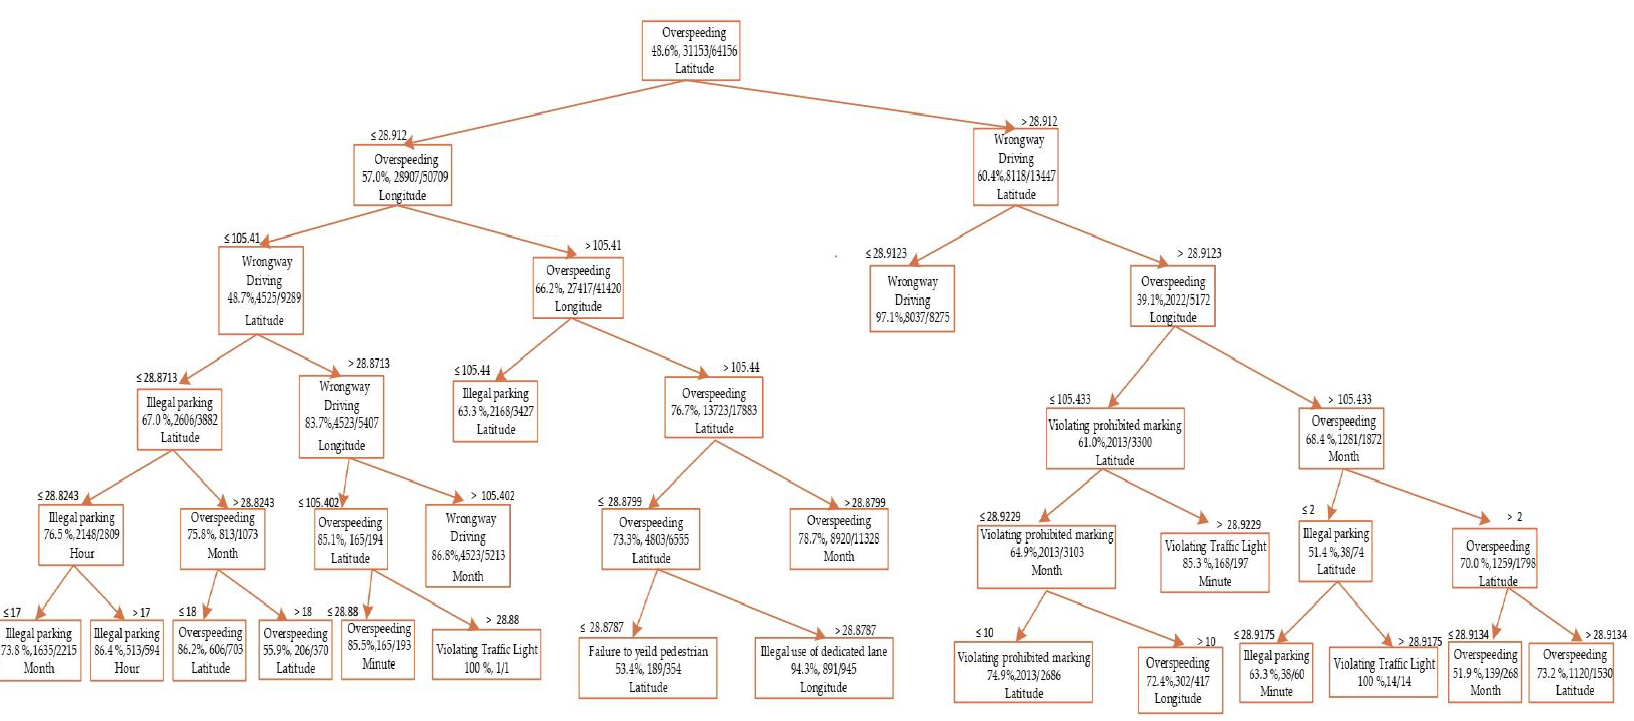
Figure 4. Prediction results of the decision tree method.